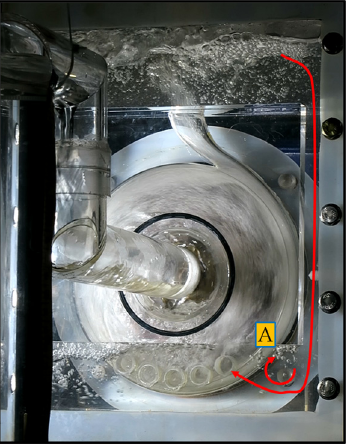
Figure 6. Gas phase reflux in the right channel of pump body.